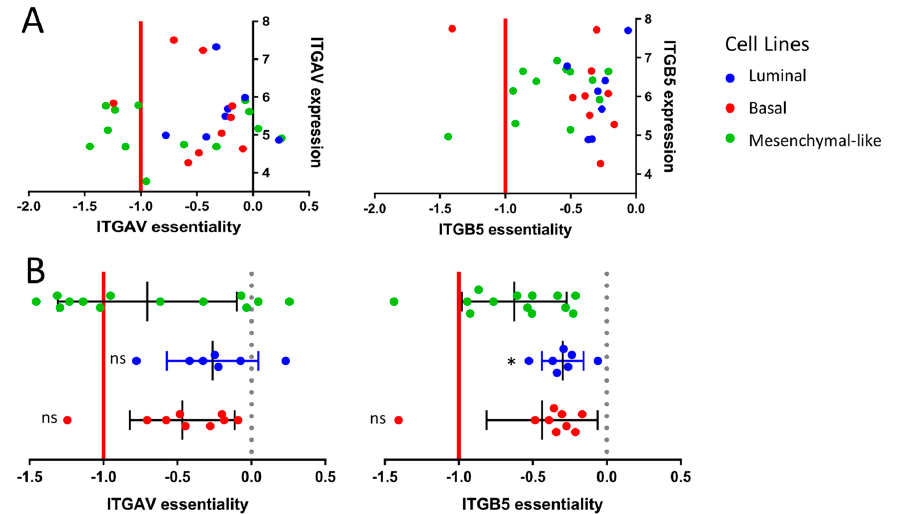
Figure 4. Functional genomics based on the CCLE cell lines. ( A ) Correlation between gene essen- tiality and gene expression based on the subtype-specific CCLE cell lines. The essentiality is calcu- lated by the CERES dependency score based on the whole genome Crispr–Cas9 knock-out data from the Project Achilles. The x-axis displays the CERES dependency score: a score of 0 indicates that a gene is not essential for cell survival, and a score near − 1 is comparable to the medians of all pan- essential genes. ( B ) Box-plot comparison of gene essentiality between the subtype-specific cell lines. ( p < 0.033: *).